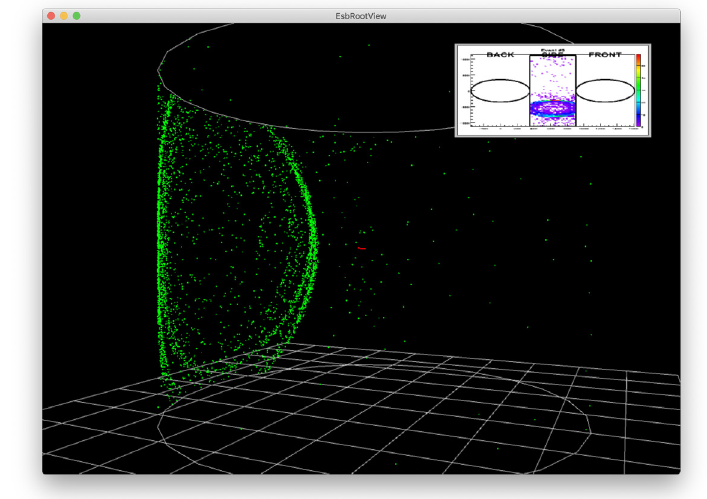
Figure 3. DetectorPoint instances in the fard.